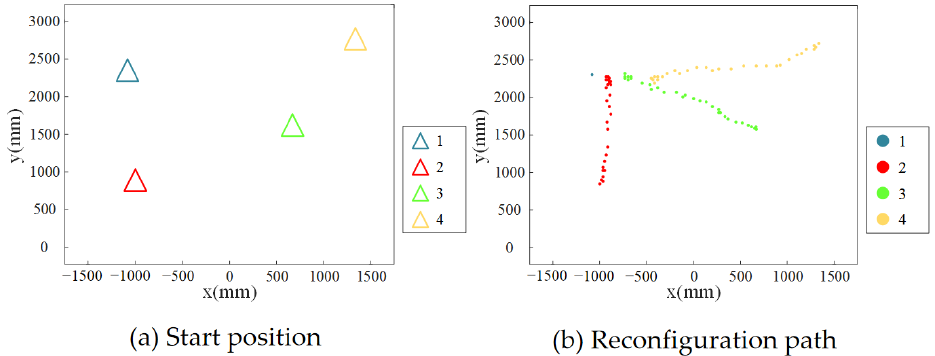
Figure 21. Visualization of the “—” shape reconfiguration process.